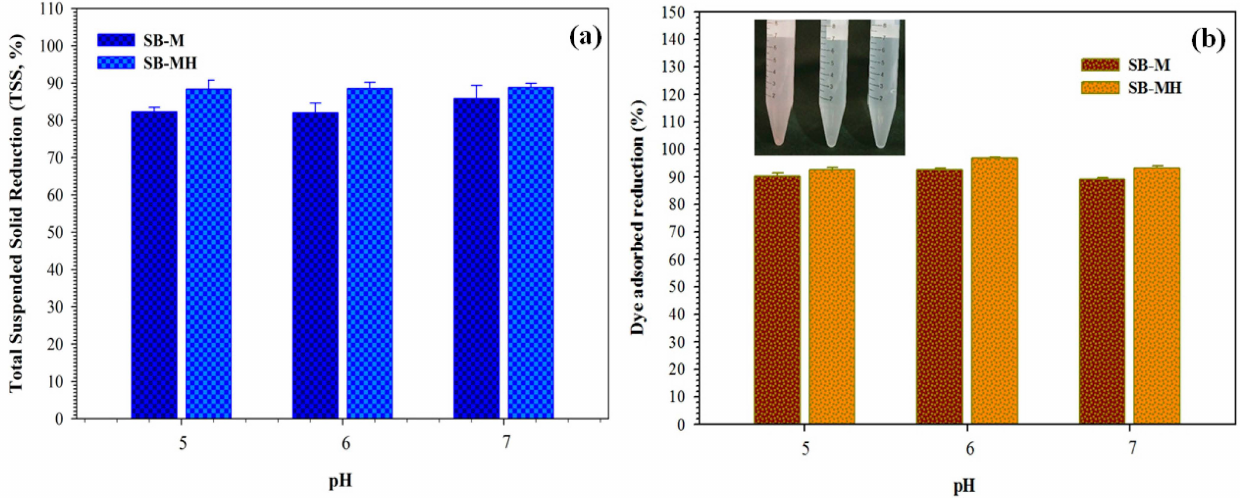
Figure 6. ( a ) TSS and ( b ) dye reduction related to the pH variations in the adsorption process with a sample volume of 300 mL, 360 min, shaking rate of 150